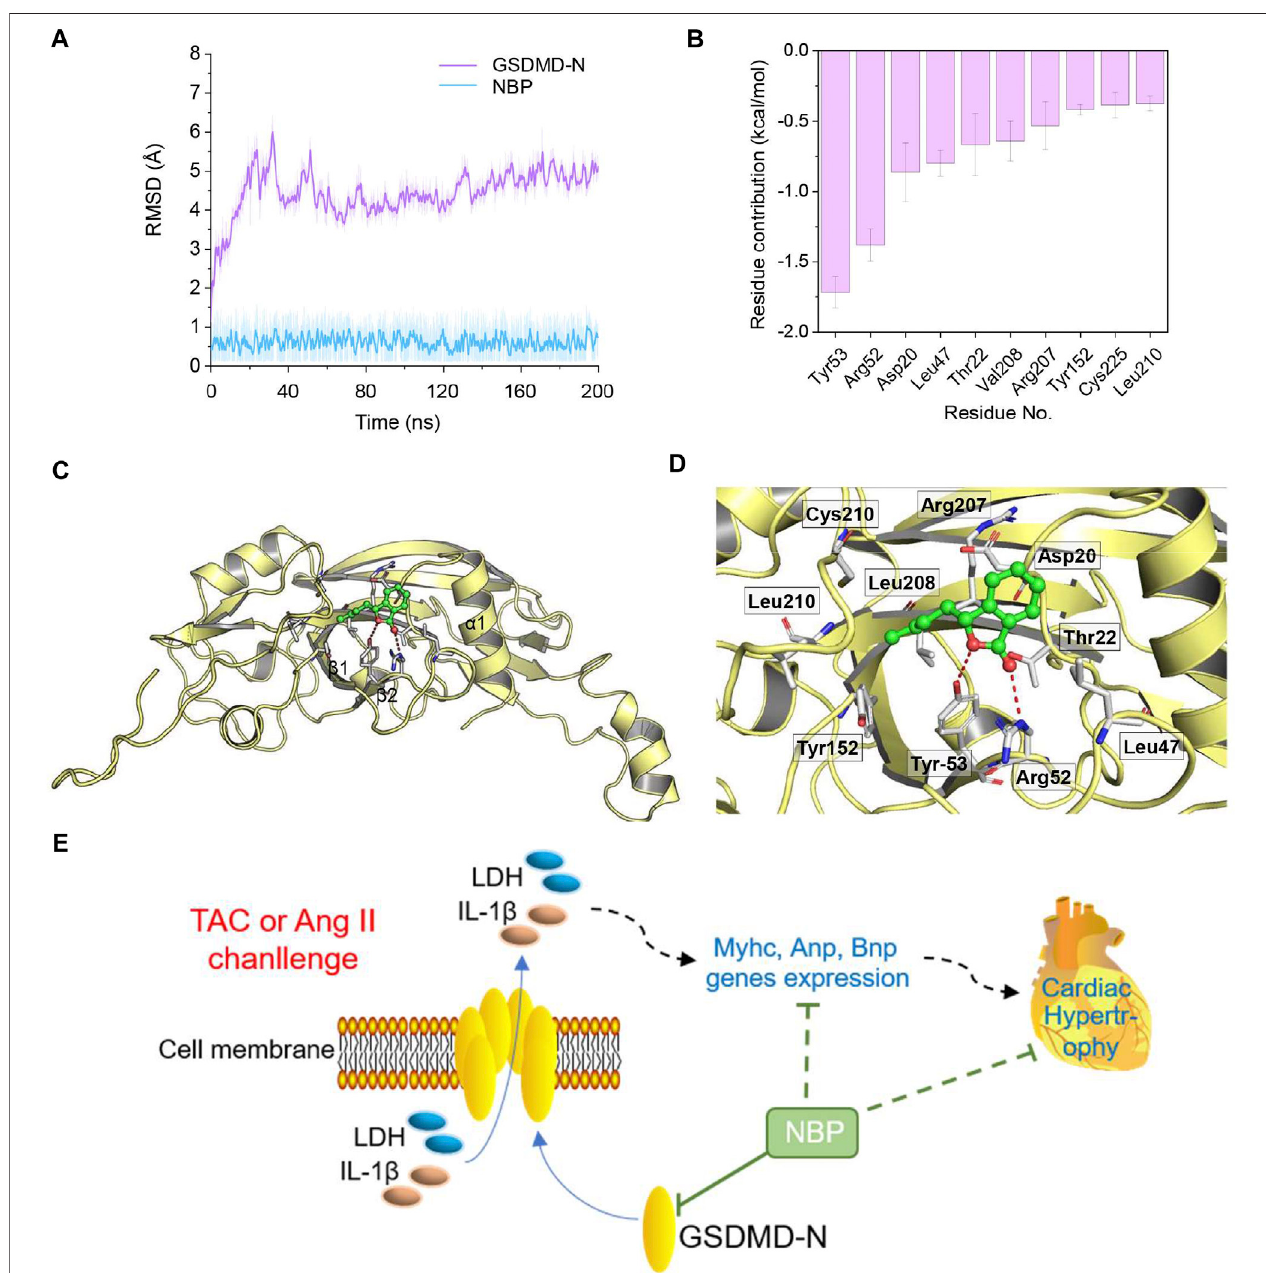
FIGURE 5 | Structural and energetic analysis of NBP to the binding site of GSDMD-N. (A) RMSD curves for the 200 ns MD simulation. (B) The 10 top contributing residuestoNBPboundtoGSDMD-N. (C) OverviewofthepredictedbindingmodebetweenGSDMD-NandNBP. (D) Detailedviewofthe10topcontributingresiduesof NBP bound to GSDMD-N and the hydrogen bonds (red). (E) Schematic illustration of the role of NBP in GSDMD-related in fl ammation in TAC- or Ang II-induced myocardial